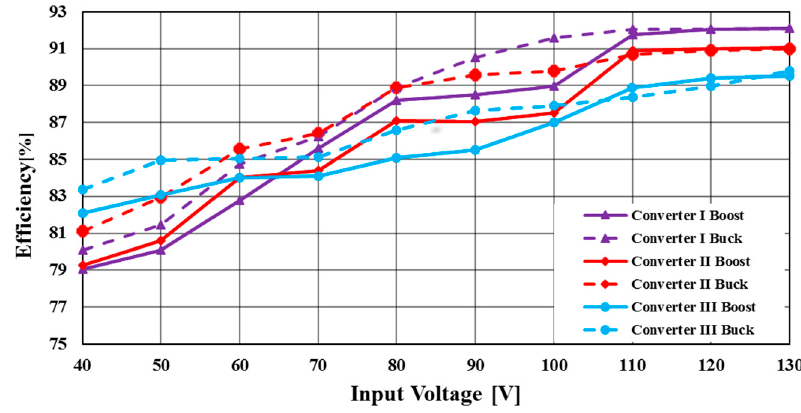
Figure 18. Efficiencies of proposed converters in boost and buck modes with U high = 250 V, U low = 40–130 V, and P o = 200 W.